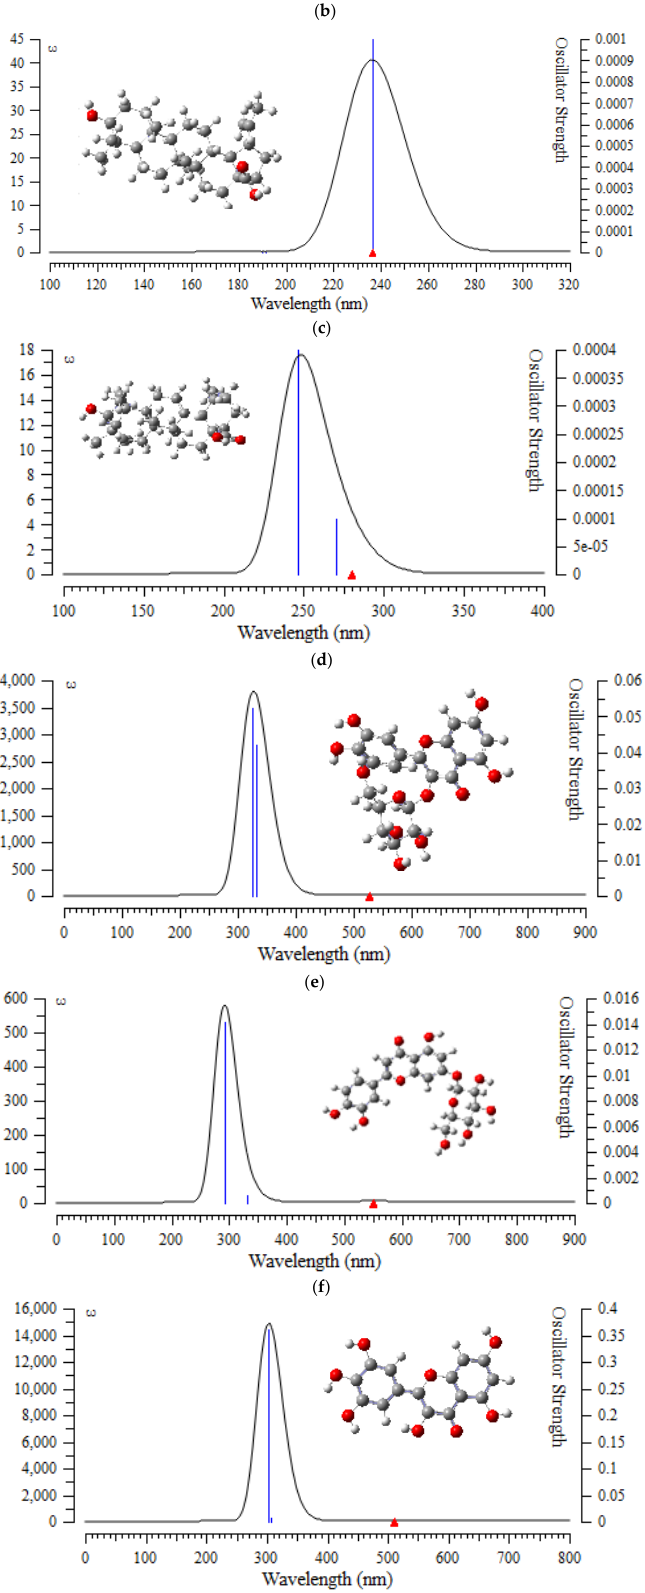
Figure 7. The UV - VIS spectra of ( a ) (+) - catechin, ( b ) betulinic acid, ( c ) ursolic acid, ( d ) querce- Figure 7. The UV-VIS spectra of ( a ) (+)-catechin, ( b ) betulinic acid, ( c ) ursolic acid, ( d ) quercetin-3-O- tin - 3 - O - galactoside, ( e ) luteolin - 7 - O - glucoside, and ( f ) myricetin in Sarracenia purpurea drug. galactoside, ( e ) luteolin-7-O-glucoside, and ( f ) myricetin in Sarracenia purpurea In the computed amounts of ultraviolet–visible (UV - VIS) spectra for (+) - catechin, betulinic acid, ursolic acid, quercetin - 3 - O - galactoside, luteolin - 7 - O - glucoside, and myri- cetin extracted from Sarracenia purpurea drug, there were maximum adsorption bands between 200 nm–300 nm for (+) - catechin, betulinic acid, ursolic acid with a sharpest peak around 230 nm (Figure 7a–c); and maximum adsorption bands between 200 nm–400 nm for quercetin - 3 - O - galactoside, luteolin - 7 - O - glucoside, and myricetin, with the sharpest peak being around 300 nm, respectively (Figure 7d–f). In fact, the intensity of the ab- sorbance of the single - walled (6,6) armchair carbon nanotube was analyzed for